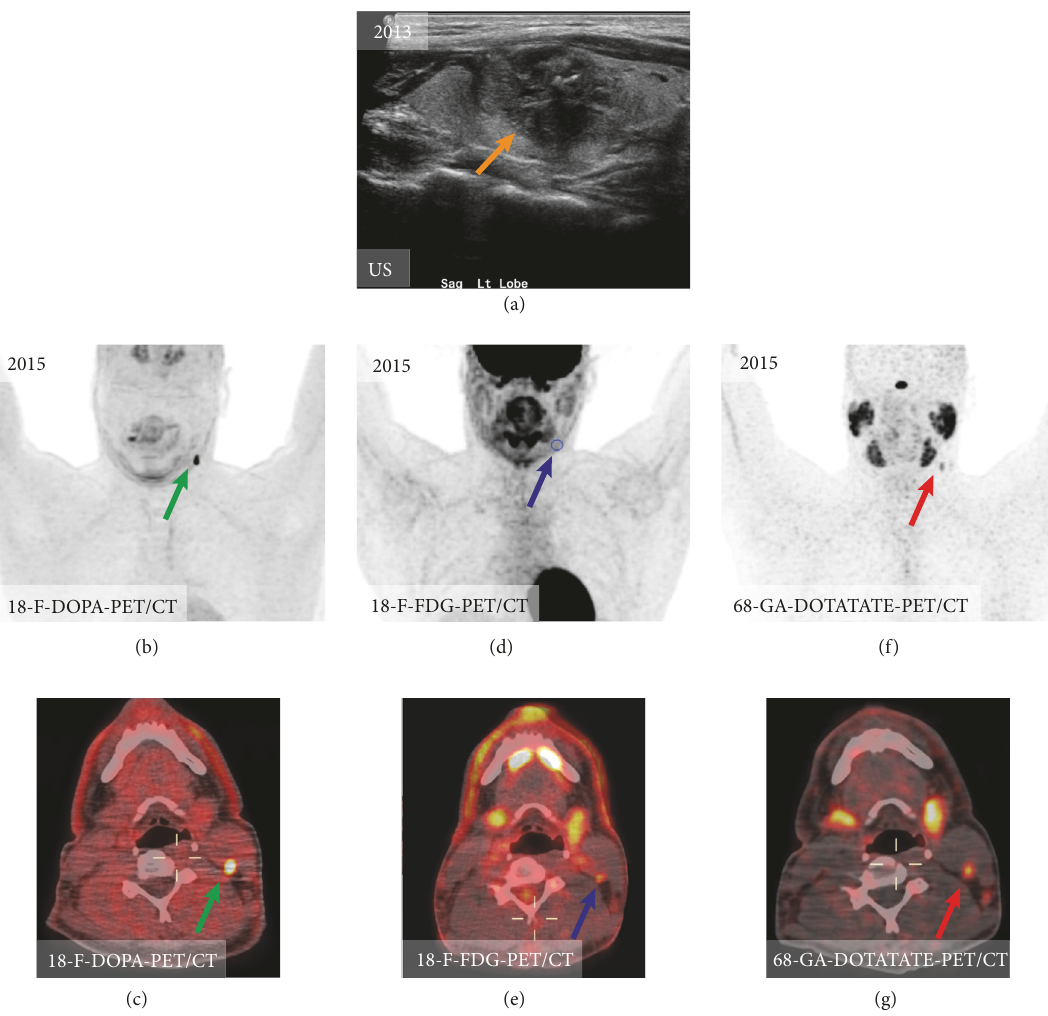
Figure 7: Mapping of the metastatic lymph nodes in medullary thyroid carcinoma. In 2015 patient underwent thyroidectomy for medullary carcinoma (a) and 2 years later presented with elevated calcitonin level (304 pg/ml). Ultrasound of the neck, CT of the neck, and MRI of the neck were all false negative (not shown); however, 18F-FDOPA-PET/CT (c), 18F-FDG-PET/CT, and 68Ga-DOTATATE-PET/CT were positive for a metastatic lymph node. Please note that patients with neck pathology should ideally be scanned with arms down (in this case the study was obtained with patient’s arms up as it was a whole-body imaging for detection mediastinal metastases).